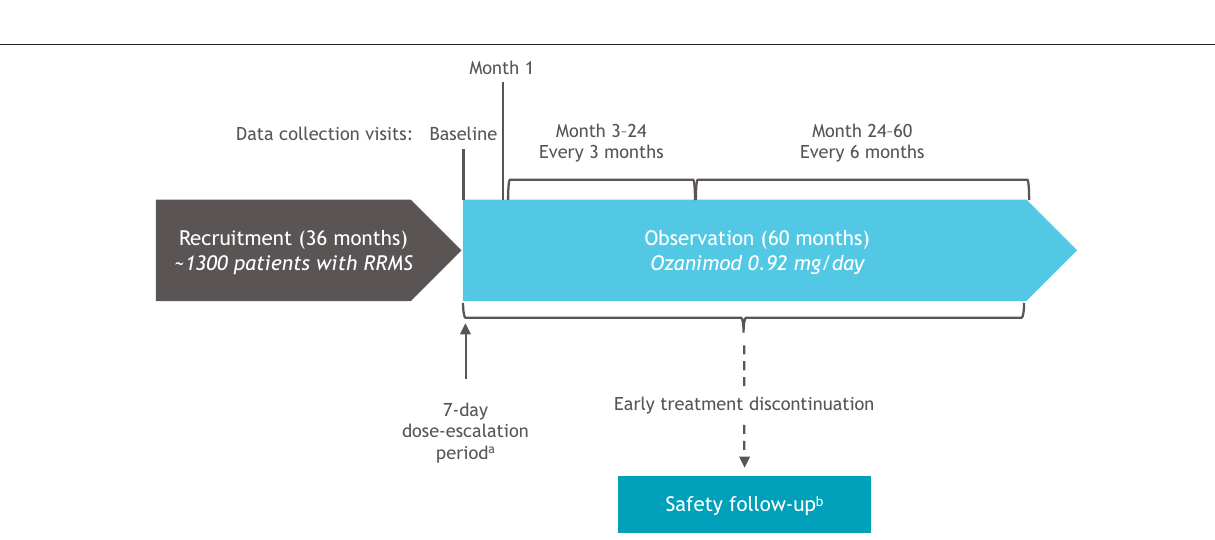
Frontiers in Neurology |